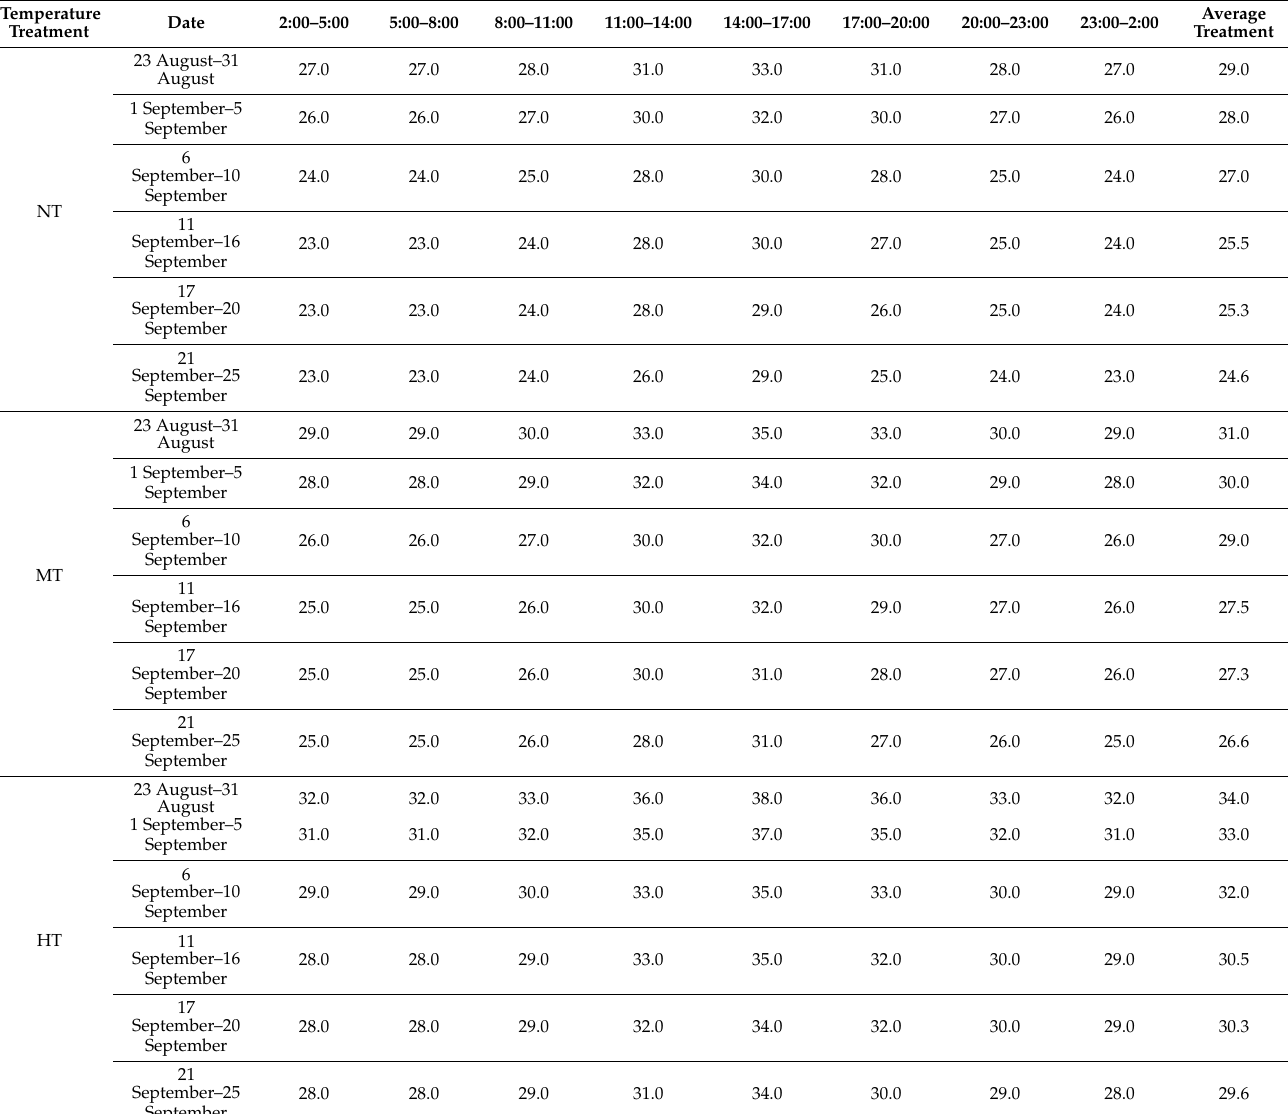
Table 1. Temperature of artificial intelligence climate